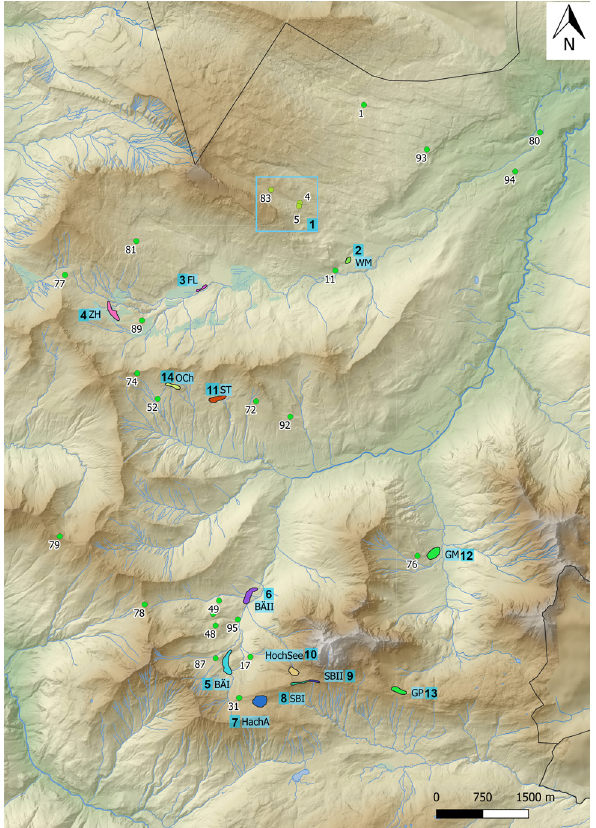
Figure 2: Archaeological sites ( green ) and site clusters ( blue ) . For a list of names of the sites, see Table 10. ( Posch, 2022; data source: Land Vorarlberg – data.vorarlberg.gv.at – 5 m DEM; Copernicus eu_dem_v11_E40N20 – 25 m DEM )